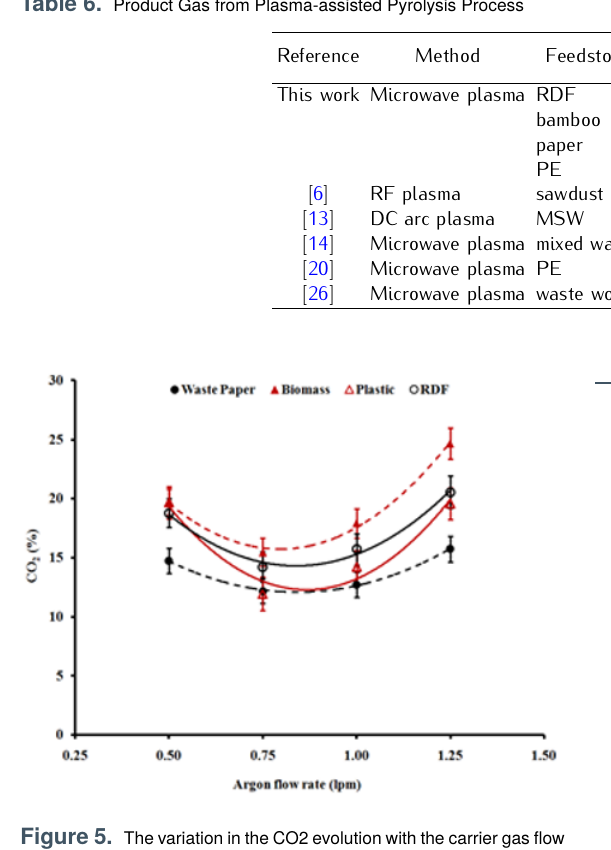
Figure 5. The variation in the CO2 evolution with the carrier gas flow rate and the type of